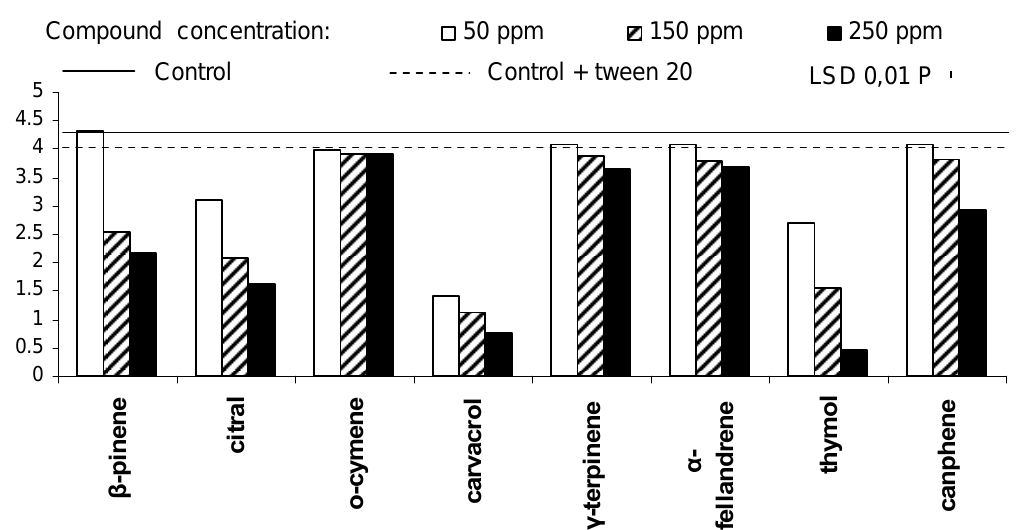
Figure 5. Antifungal activity of the eight plant essential oil components against Penicillium expansum